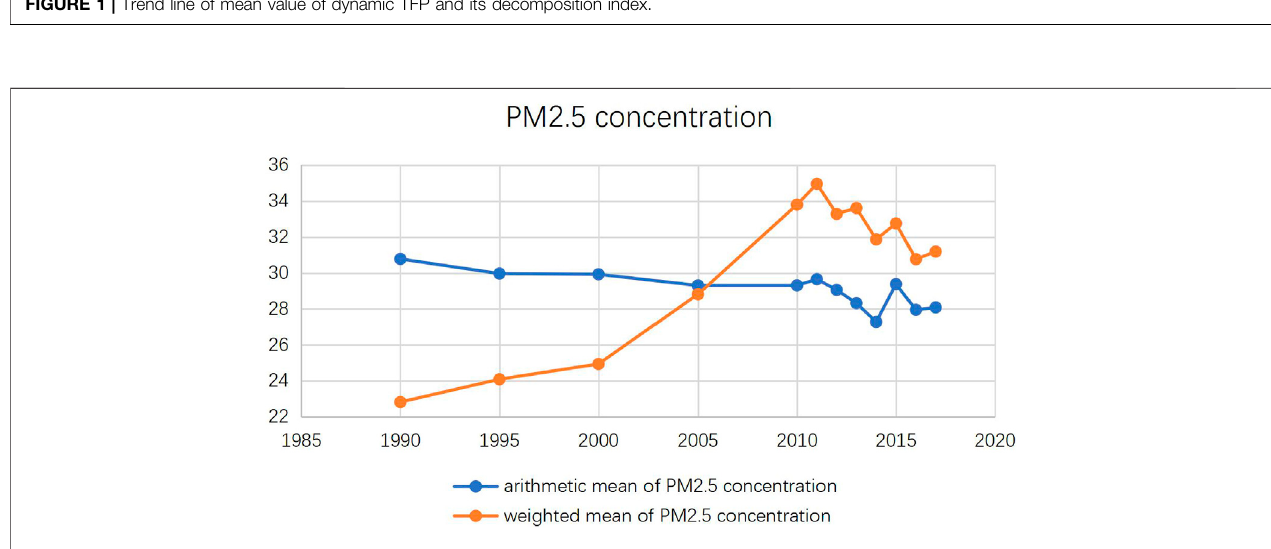
FIGURE 2 | Trend line of mean value of PM2.5 concentration.